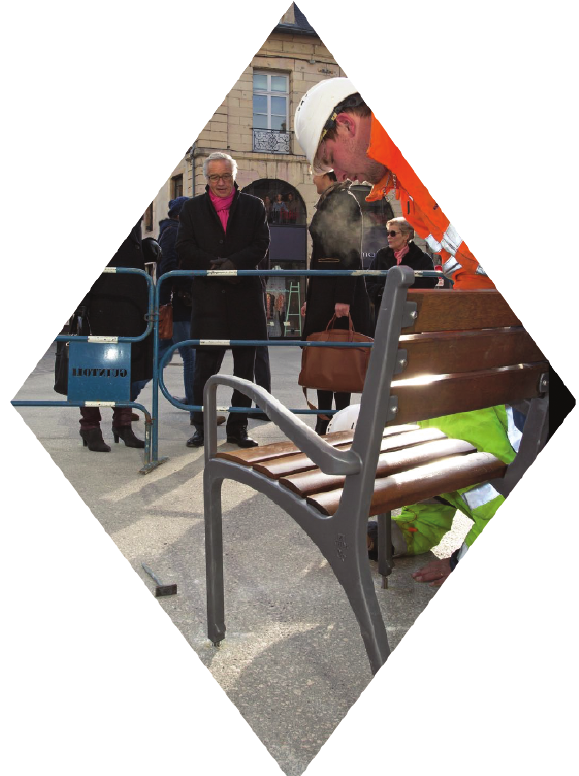
Figure 7. Installation of a bench under the supervision of a Mayor. The promotional document here refers to “A participatory democracy challenge”. Source : Lefebvre and Chapon (2014, p. 38).